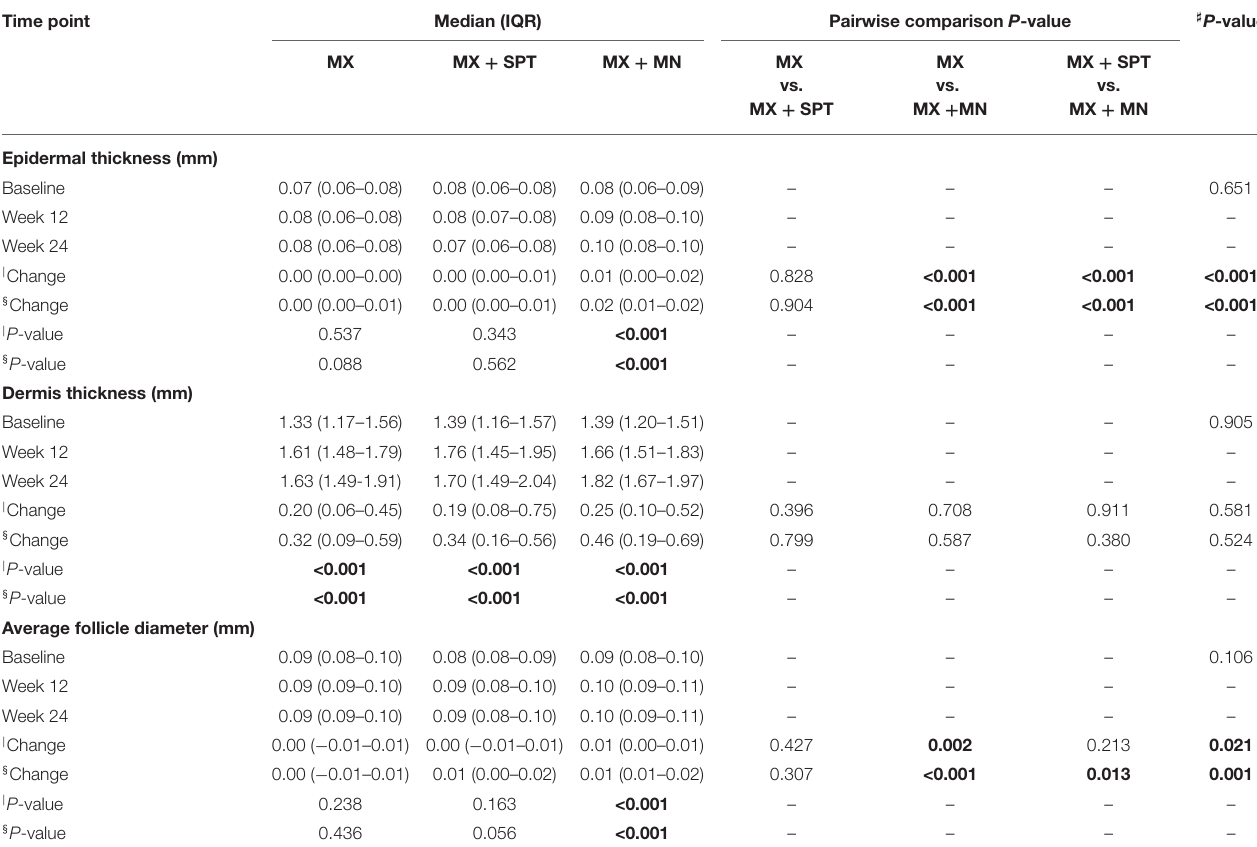
TABLE 3 | UBM assessment during the study period among the three groups. Time